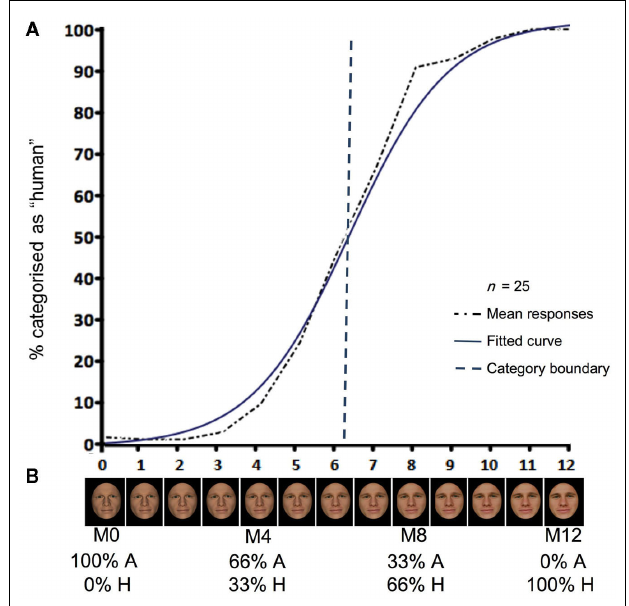
FIGURE 2 | Results of the forced choice classification task (A) and example of a morph continuum (B). Mean percentage of responses (across 25 participants) in the forced choice classification task (A) , showing the grand average of the response data (dashed black line), the fitted logistic response curve (solid blue line), and the estimated mean category boundary value (blue dashed line) over all continua. Results indicate a step-like response function consistent with the presence of a category boundary. Example of a morph continuum (B) with 13 levels from M0 to M12.The relative degree of linear physical transition between the avatar (eg., 100% A) and human (eg., 0% H) endpoints of morphs M0 and M4 (avatar category) and M8 and M12 (human category) are shown as percentages.The controlled physical dissimilarity of M0, M4, M8, and M12 was 33% along the continuum.These morphs were used in the subsequent perceptual discrimination task and fMRI